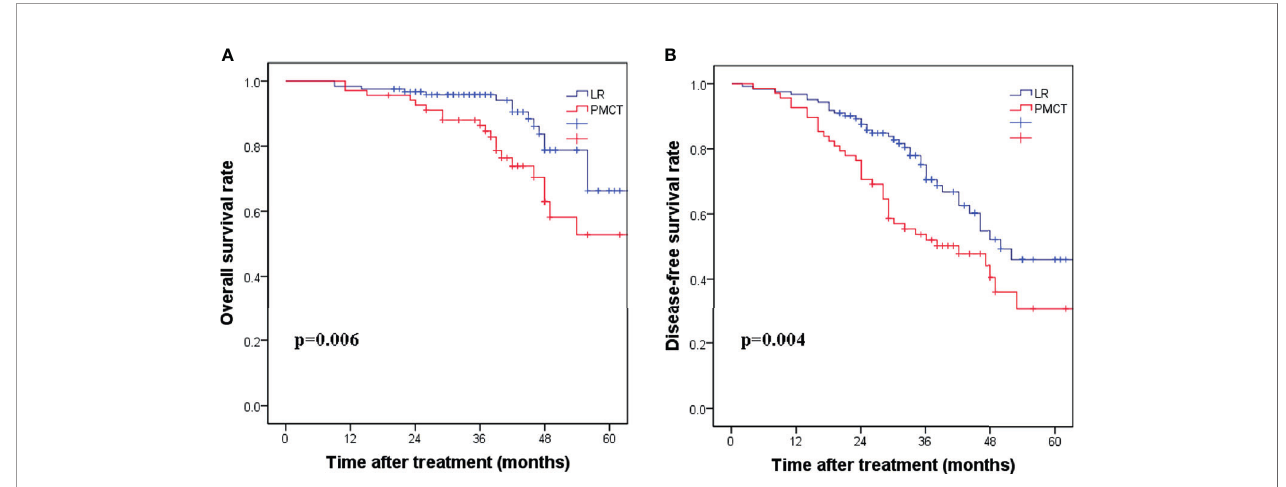
FIGURE 1 | (A) The corresponding 1-, 3-, and 5-year disease-free survival rates in the LR group compared with the PMCT group. ( p = 0.004). (B) The corresponding 1-, 3-, and 5-year overall survival rates in the LR group compared with the PMCT group. ( p = 0.006). LR, liver resection; PMCT, percutaneous microwave coagulation